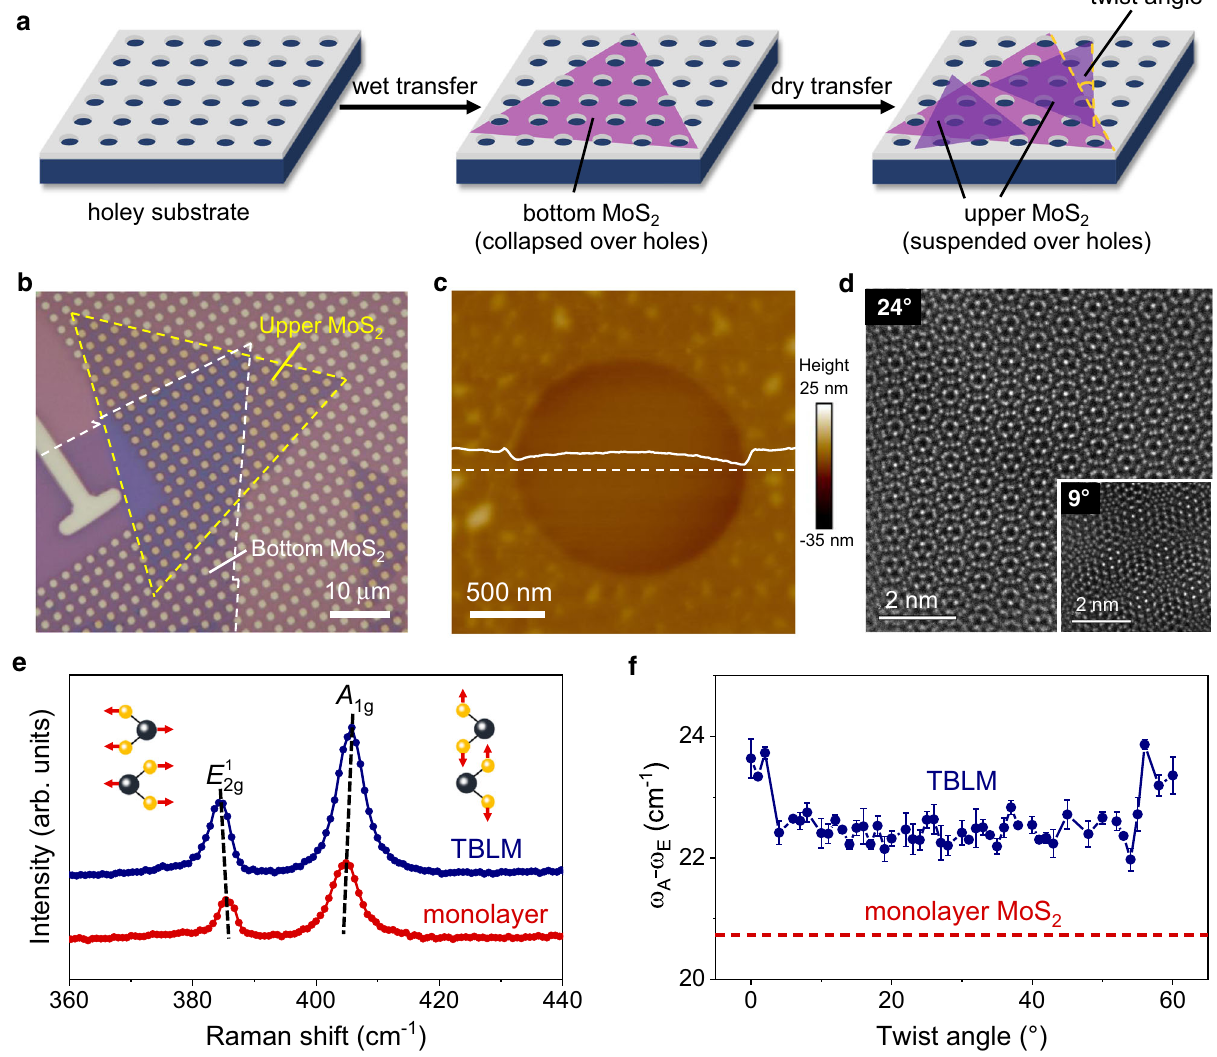
Fig. 1 Preparation and characterization of twisted bilayer MoS 2 (TBLM). a Schematic diagram of the preparation of TBLM. Here, the bottom layer MoS 2 collapses over the holes, while the upper layer is suspended over the holes. b Optical image of a TBLM sample. The dashed lines represent the edges of upper and bottom MoS 2 monolayers. c Atomic force microscope surface topology image of TBLM over a single hole. The white solid line is the height pro fi le of the sample across the white dashed line. The variation of the height pro fi le is 4.1 nm. d Clear Moiré patterns of TBLM at twist angles of 24° and 9° (inset) observed under annular dark- fi eld scanning transmission electron microscopy. e Comparison of the Raman spectra of TBLM and monolayer MoS 2 . The increase in peak interval is illustrated by the two black dashed lines. The inset shows the vibrational modes of E 1 the peak interval in TBLM samples on a SiO 2 /Si substrate. The red dashed line indicates the peak interval between E 1